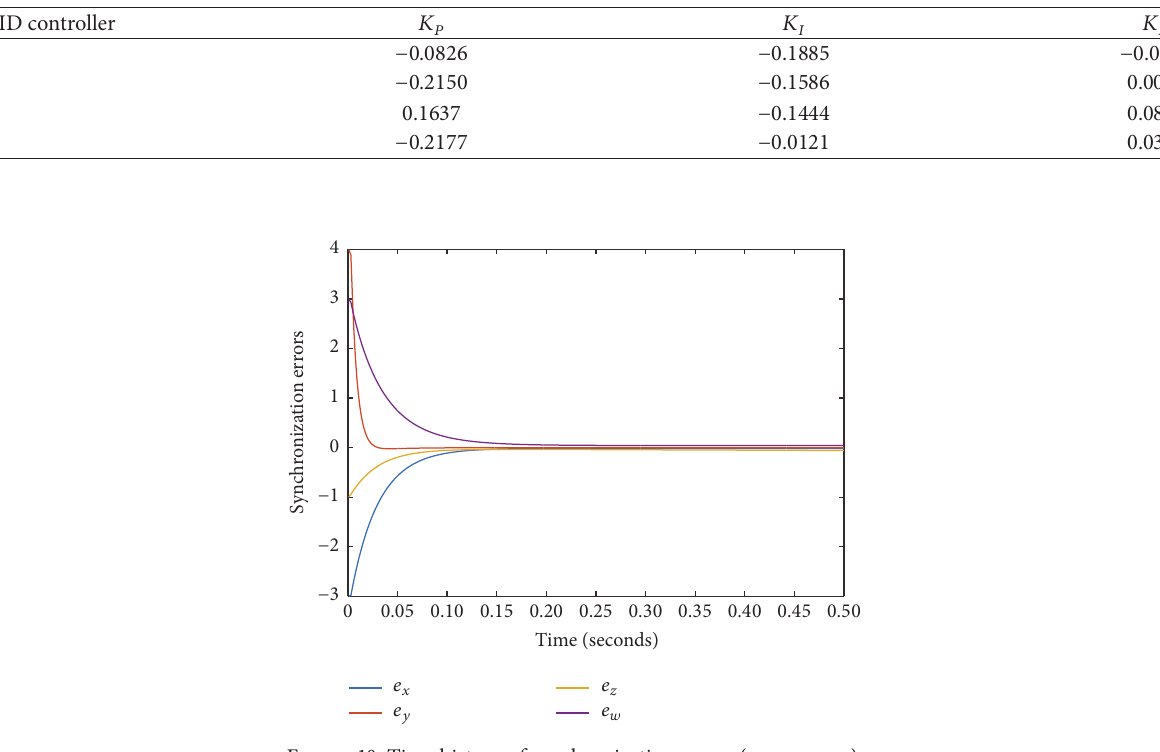
Figure 10: Time history of synchronization errors ( 𝑒 𝑥 ,𝑒 𝑦 ,𝑒 𝑧 ,𝑒 𝑤 ).